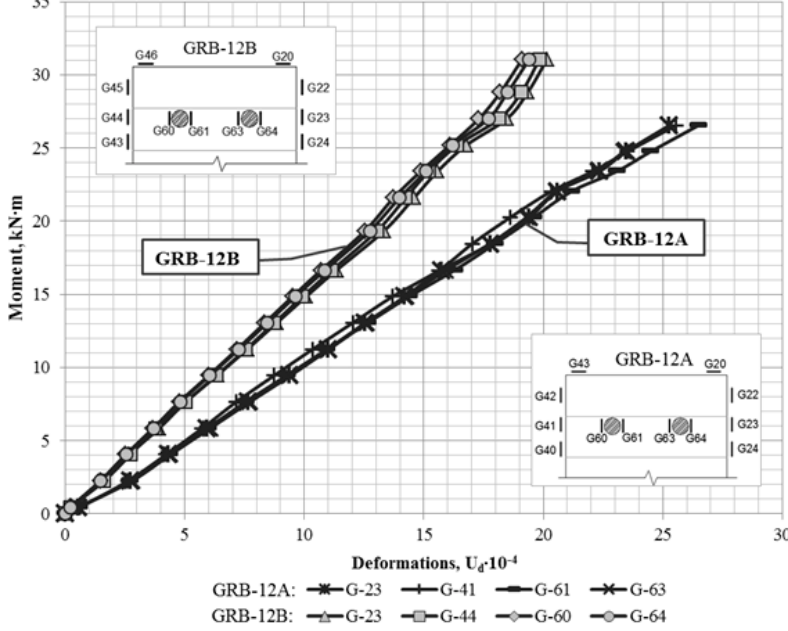
Figure6. Figure 6. G raphical charts of wood- and steel-reinforcement deformations of GRB-12A and GRB-12B beams.